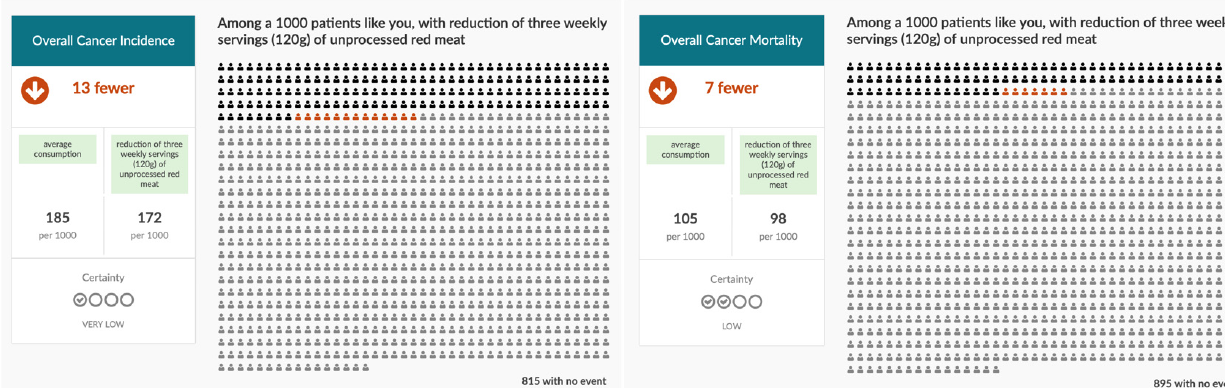
Figure 2. Three servings/week scenarios for unprocessed red